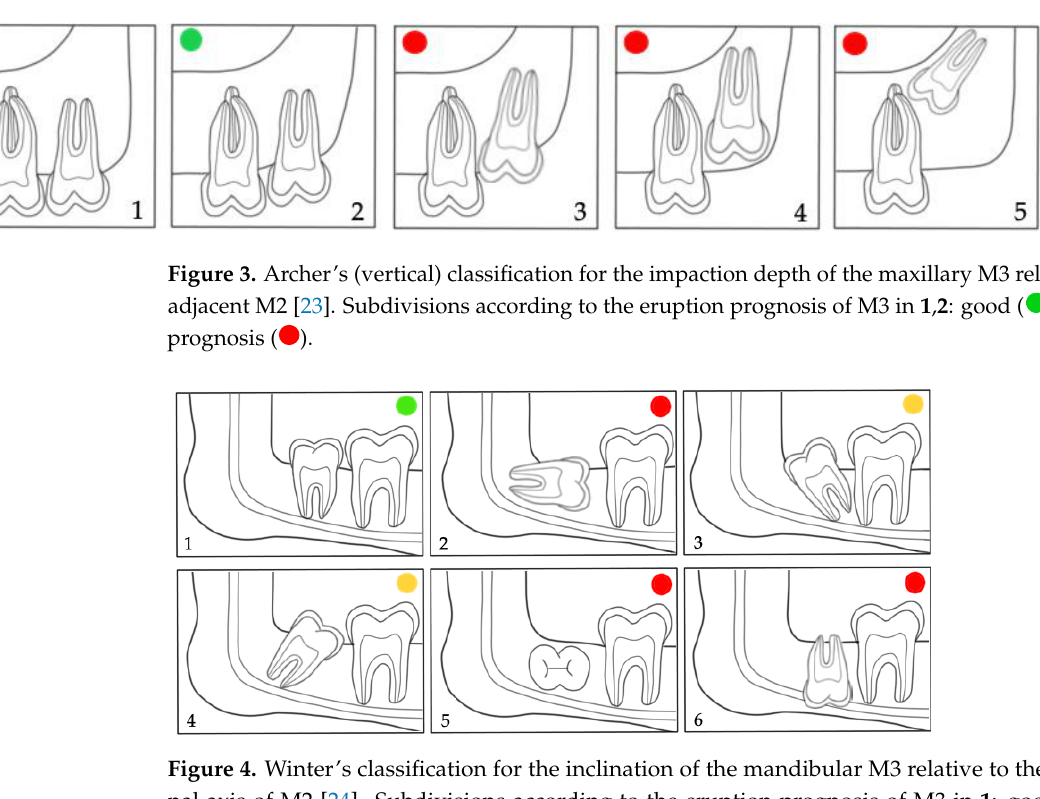
Figure 4. Winter’s classification for the inclination of the mandibular M3 relative to the longitudinal axis of M2 [24]. Subdivisions according to the eruption prognosis of M3 in 1 : good ( ); 3 , 4 : ques- tionable ( ); 2 , 5 , 6 : bad prognosis ( ).